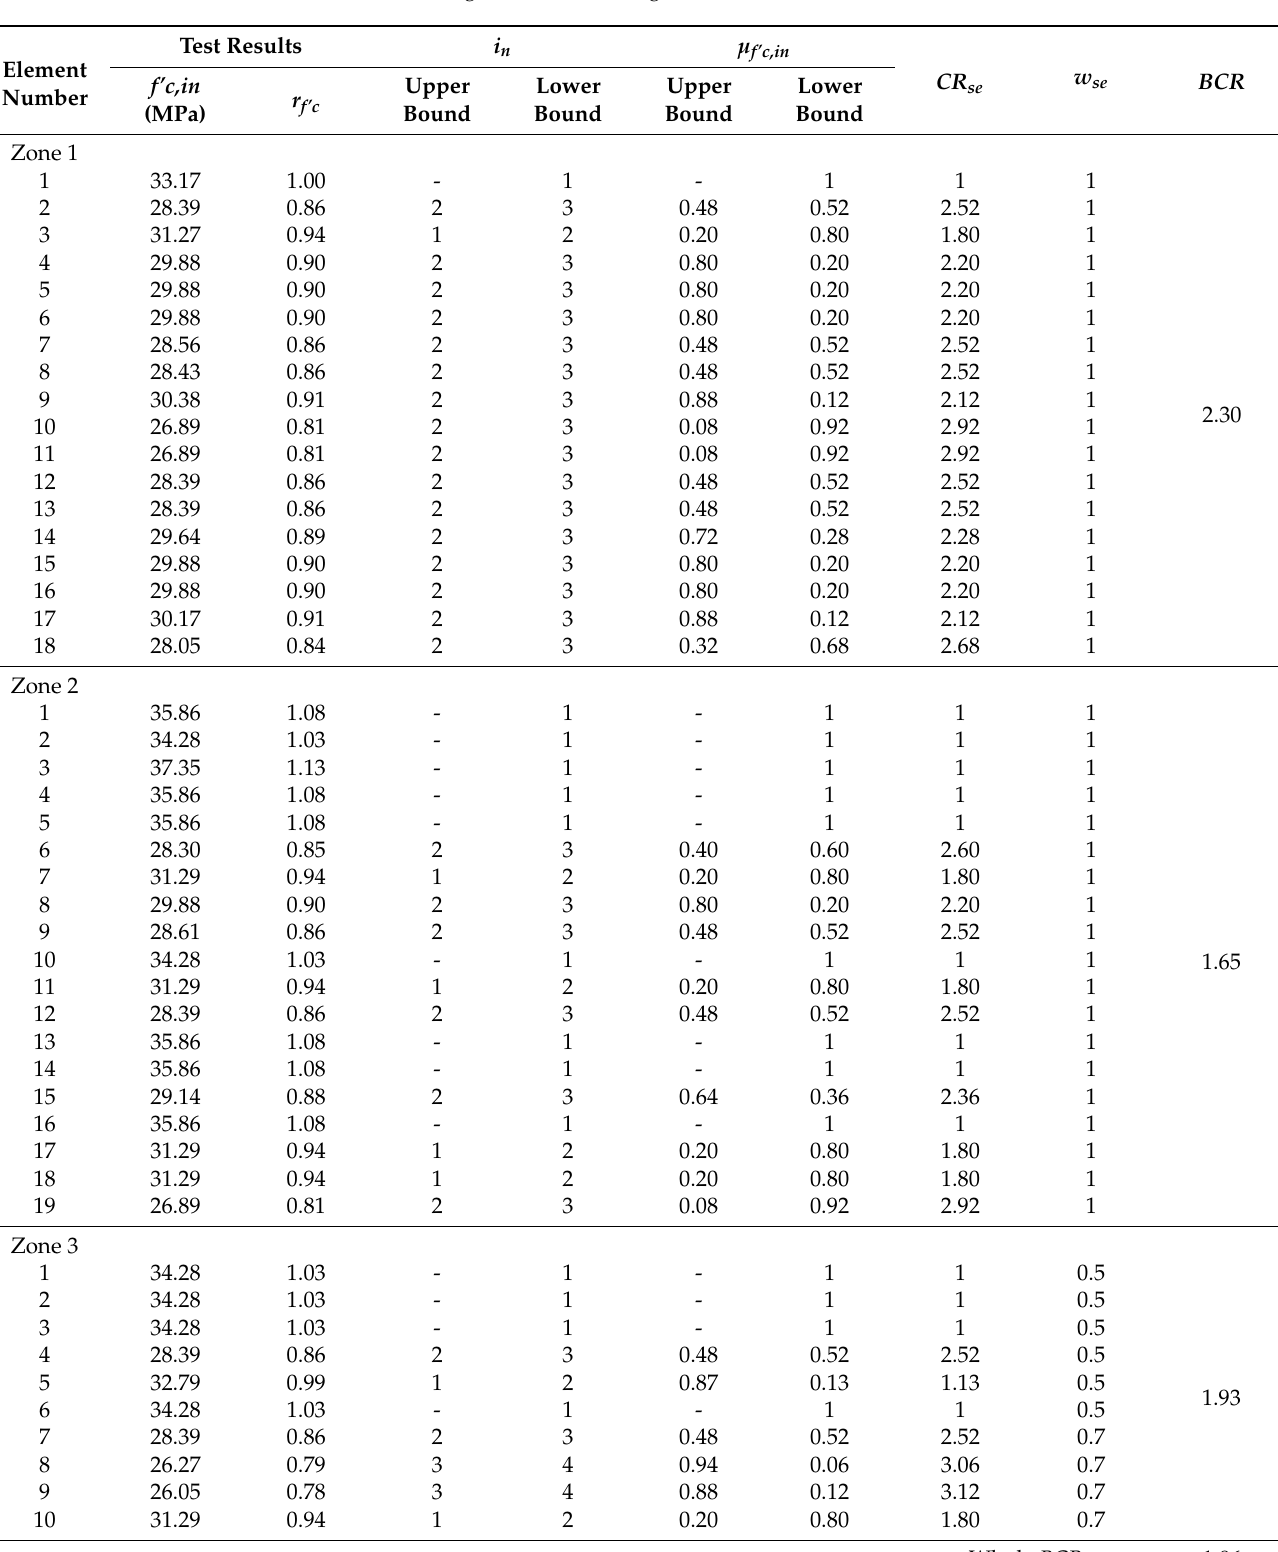
Table 7. Building B condition rating